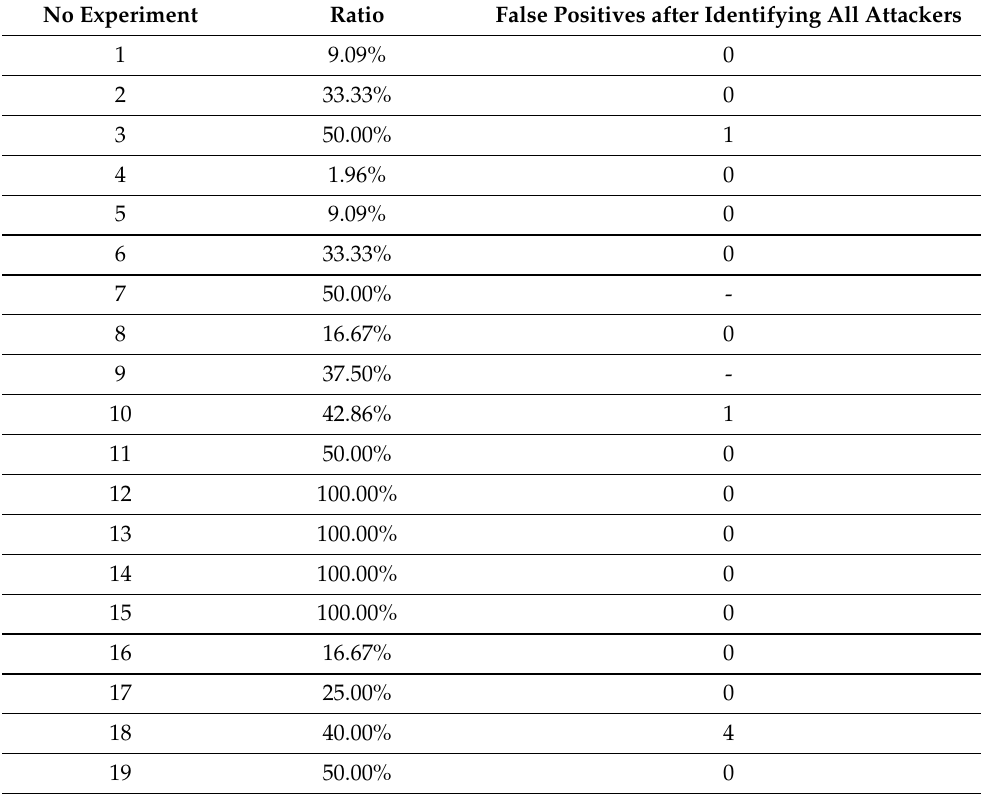
Table 6. Bogus & Sybil Trust Level & Timestamp algorithm—users incorrectly qualified as attackers (false positives after identifying all